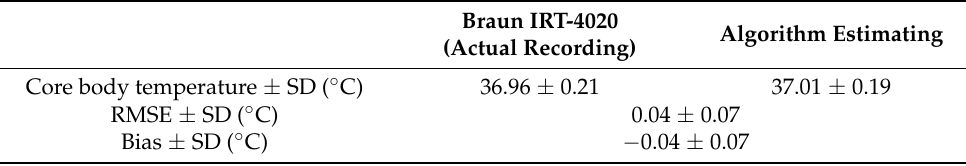
Table 5. Core body temperature estimation algorithm results (healthy participant).